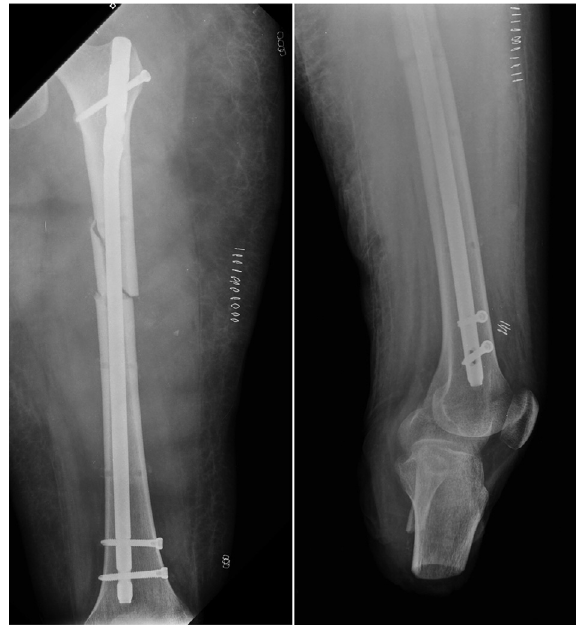
Figure 3. Definitive femoral nail osteosynthesis.